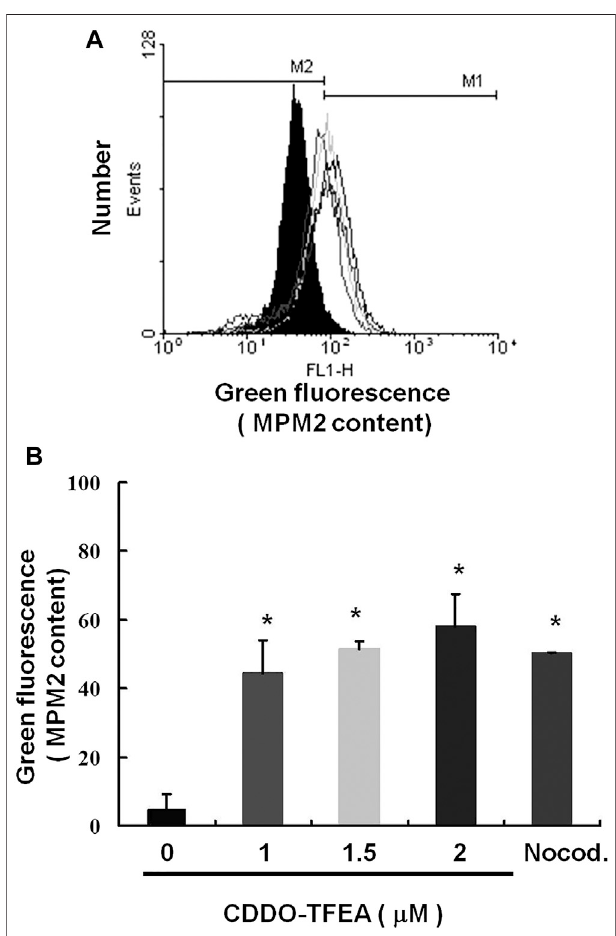
FIGURE 6 | Cell failure to pass the G2 checkpoint leads to cell cycle arrestintheG2/MPhaseinGBM8401Cells.FlowcytometryanalysisofMPM- 2 expression in the treated cells was conducted. (A) Cells were either treated or not treated with 0, 1, 1.5, or 2 μ M CDDO-TFEA. After 24 h of treatment, cells were fi xed with 70% ethanol, stained with MPM-2 and Propidium Iodide (PI), and analyzed using FACScan software. (B) Results are expressed as a percentage of the control, with the control being 100%. All data are reported as means ± standard errors of the mean on the basis of the results of at least three separate experiments. Statistical analysis was performedusingthe t test,withdifferencesbetweenthetreatmentandcontrol groups considered signi fi cant at p < 0.05, as denoted by